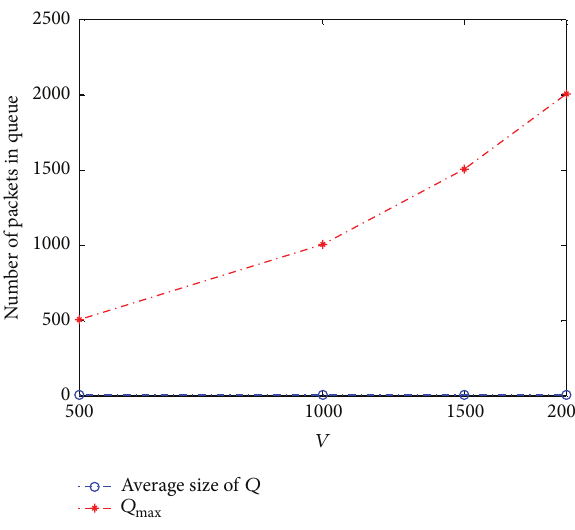
Figure 1: Throughput utility versus average data arrival rate.